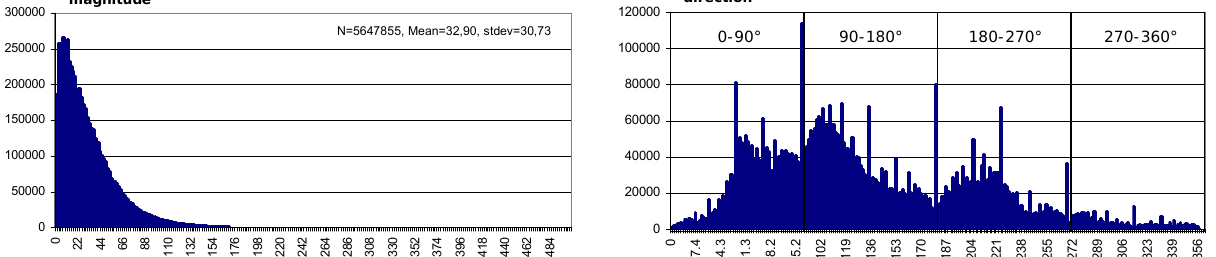
Fig. 10. Frequency distributions of change vector’s magnitude and direction.